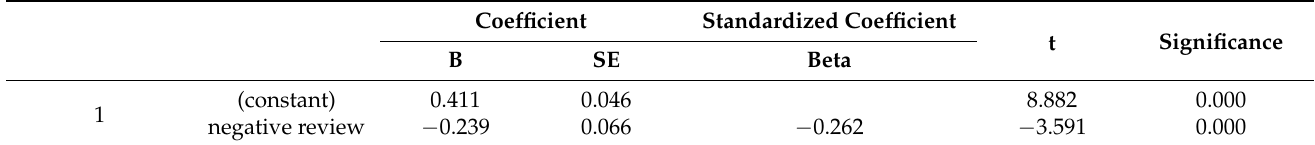
Table 16. Regression coefficients1 of Experiment B a .